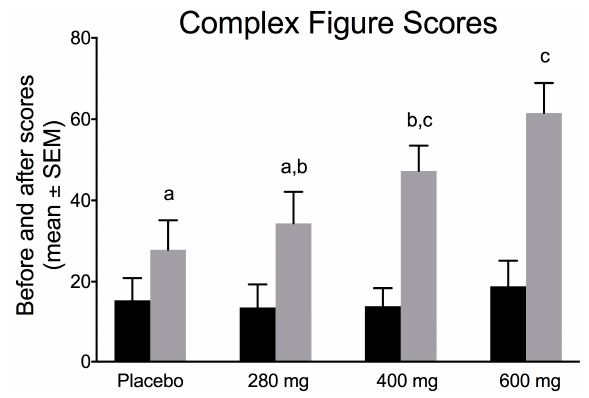
Figure 6. Korean version of the Rey Complex Figure Test (KCFT) memory test scores (as percentage of correct copying/recall) are exhibited on the y -axis. Baseline scores (black bars) for each group were similar. The percent change in drawing/recall score between groups before and after 3 weeks of daily fibroin protein enzymatic hydrolysate (FPEH) intake was increased in a dose-dependent manner (ANOVA = 0.0092). The 280 mg group change was not different from the placebo change ( p = 0.5493); however, 400 mg ( p = 0.0497) and 600 mg ( p = 0.0032) group changes were significantly increased over the placebo group and were similar to each other ( p = 0.1492). Each value is the mean with the SEM. Groups with a different alphabetical letter are statistically significantly different on the basis of t -tests.